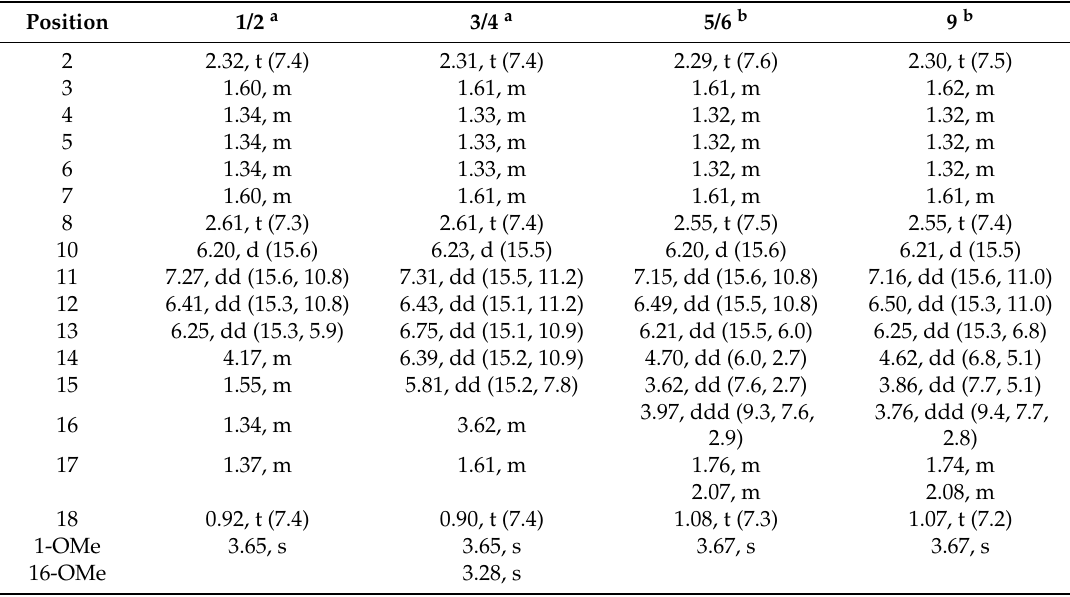
Table 1. 1 H NMR data for 1 – 6 and 9 (600 MHz).